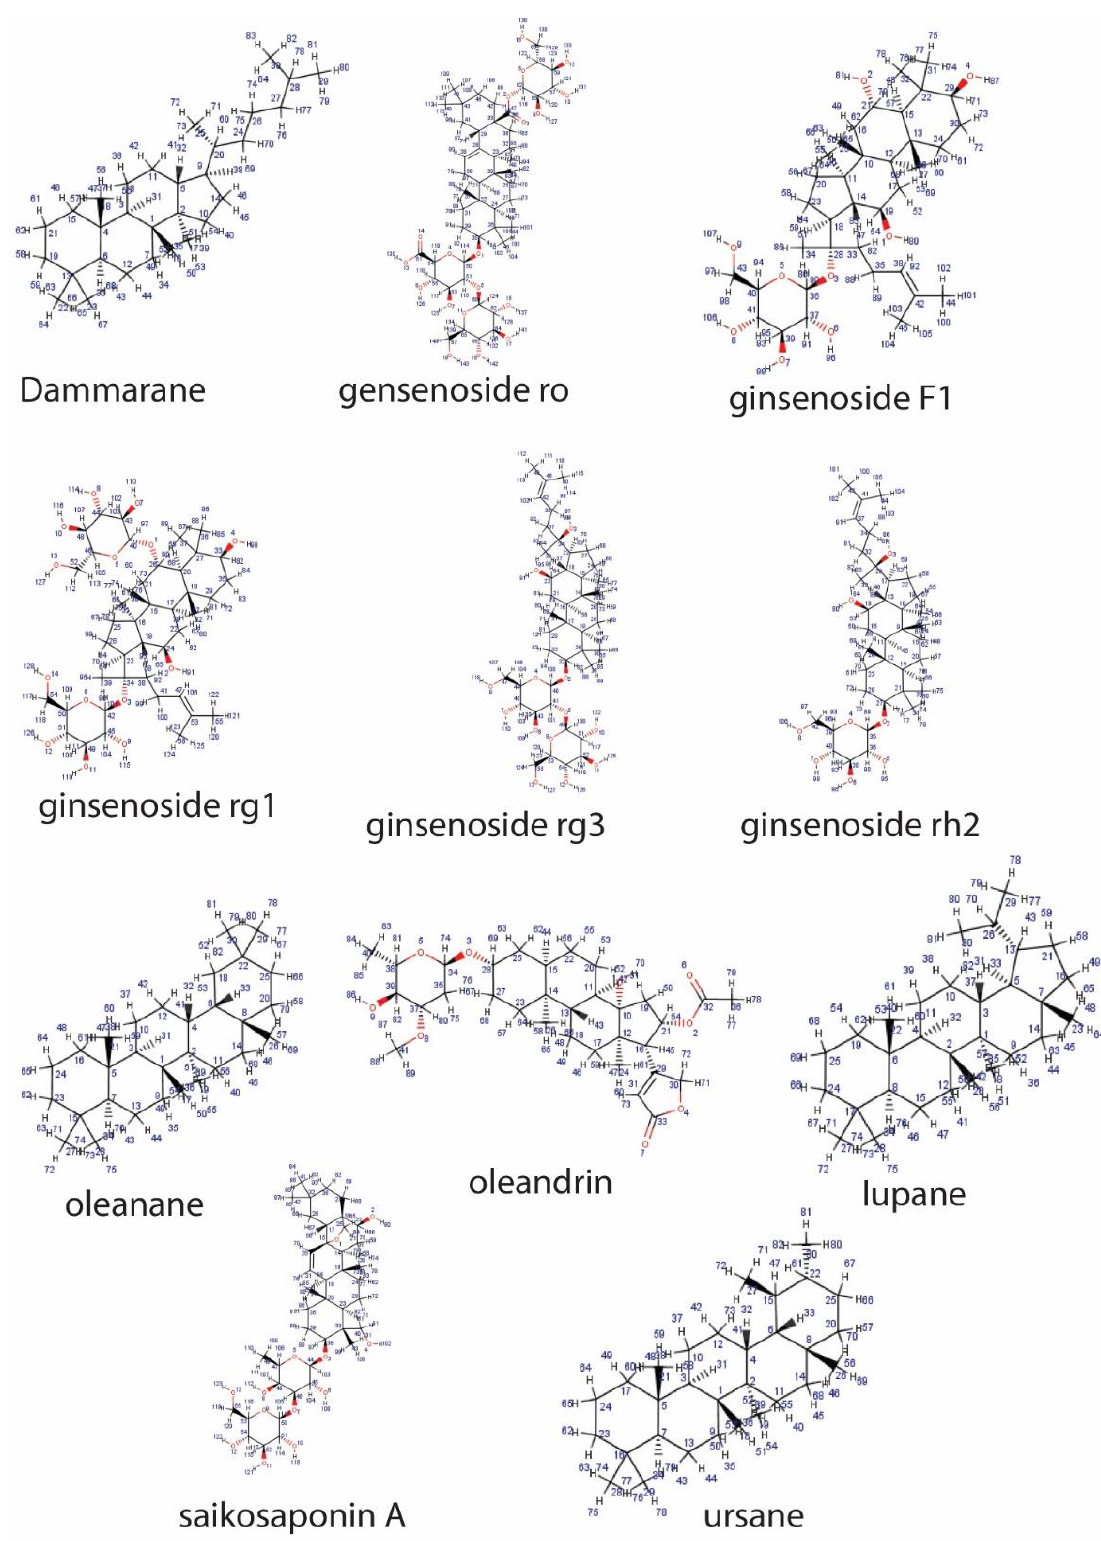
Figure 1. Representative sapogenin structure of triterpenoid saponins.